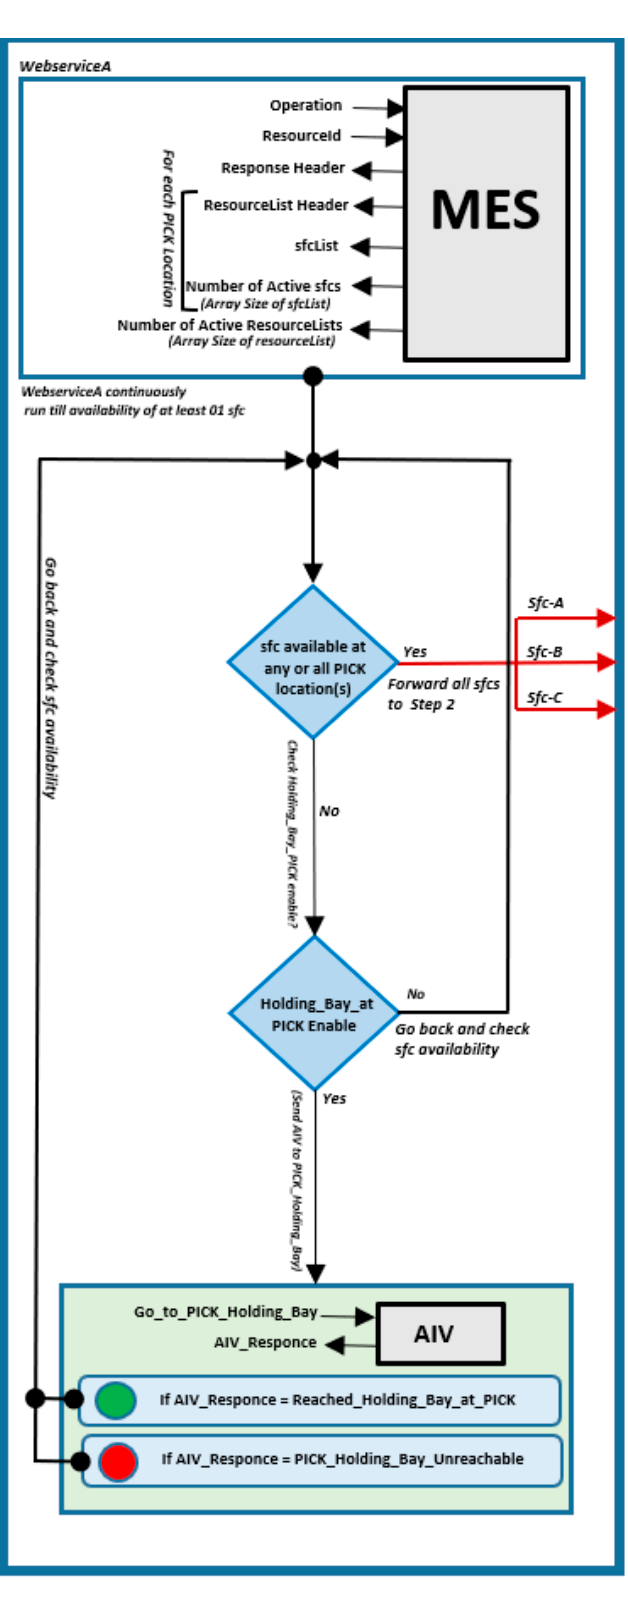
Figure 10. Check status of pickup locations.